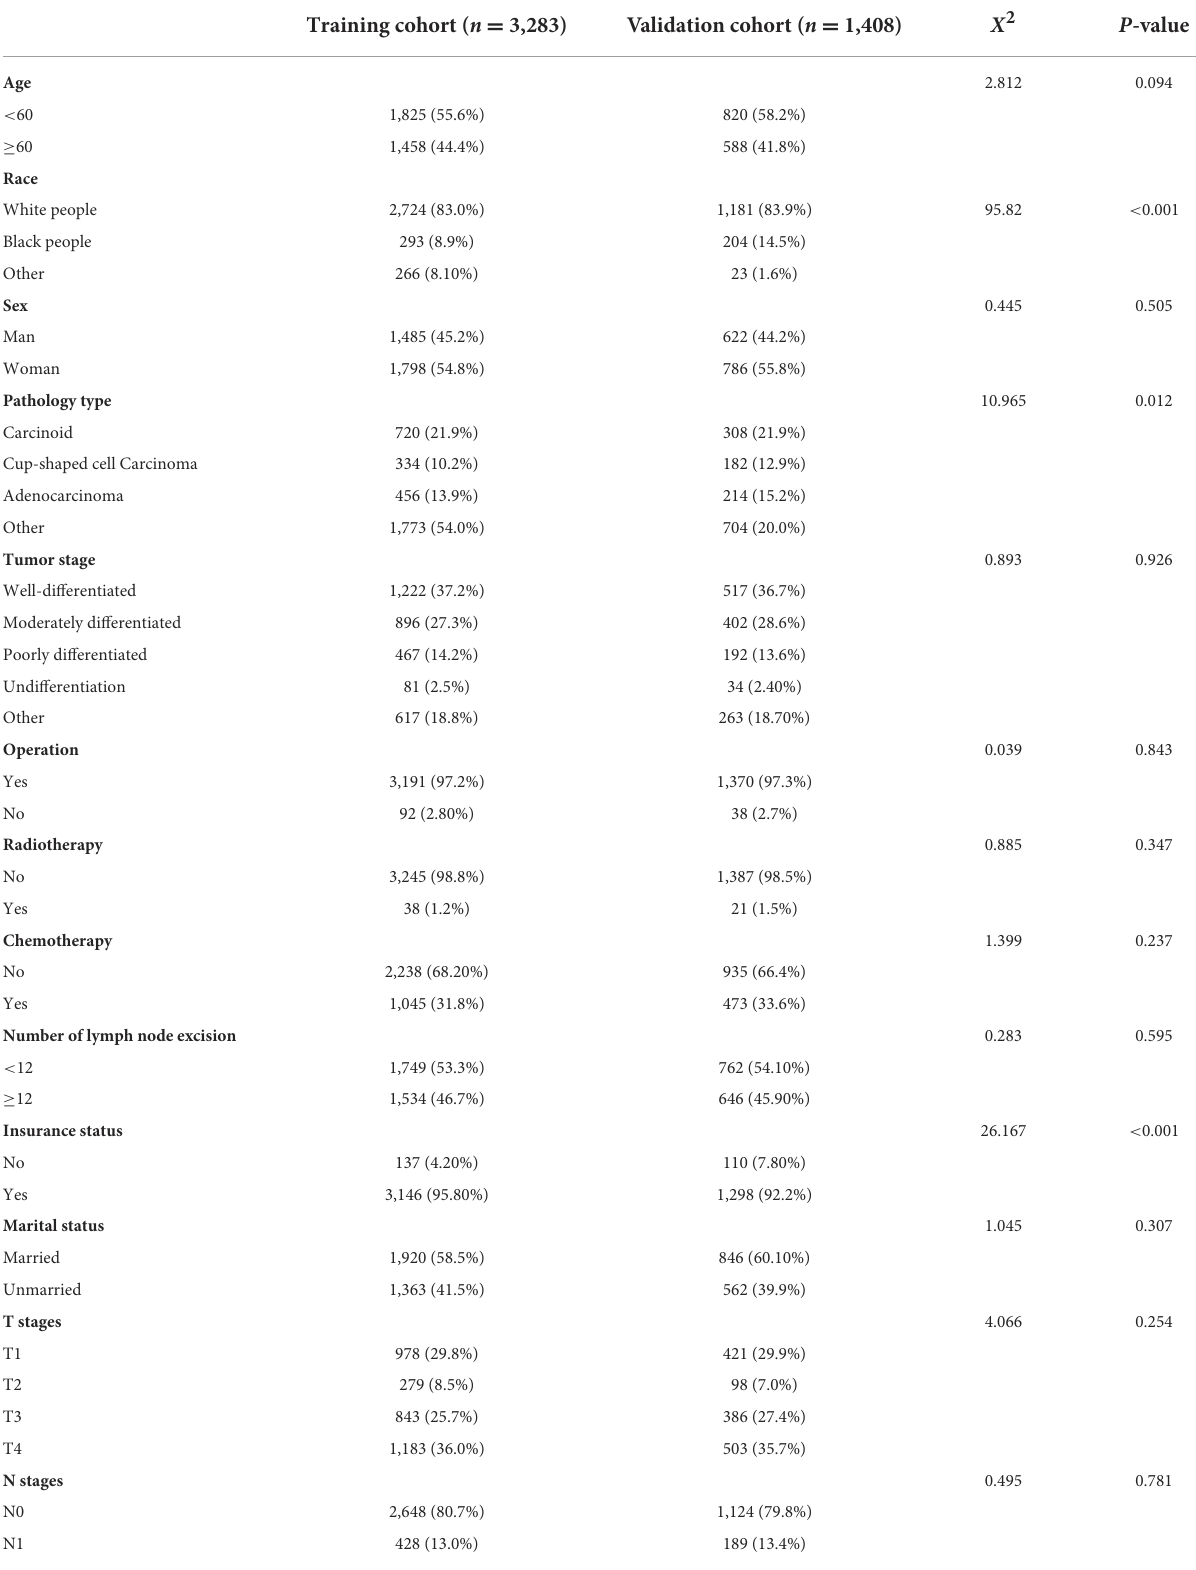
TABLE 1 Analysis of clinical case data for appendix